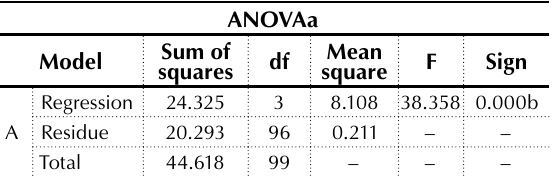
Table 10. ANOVA of model A